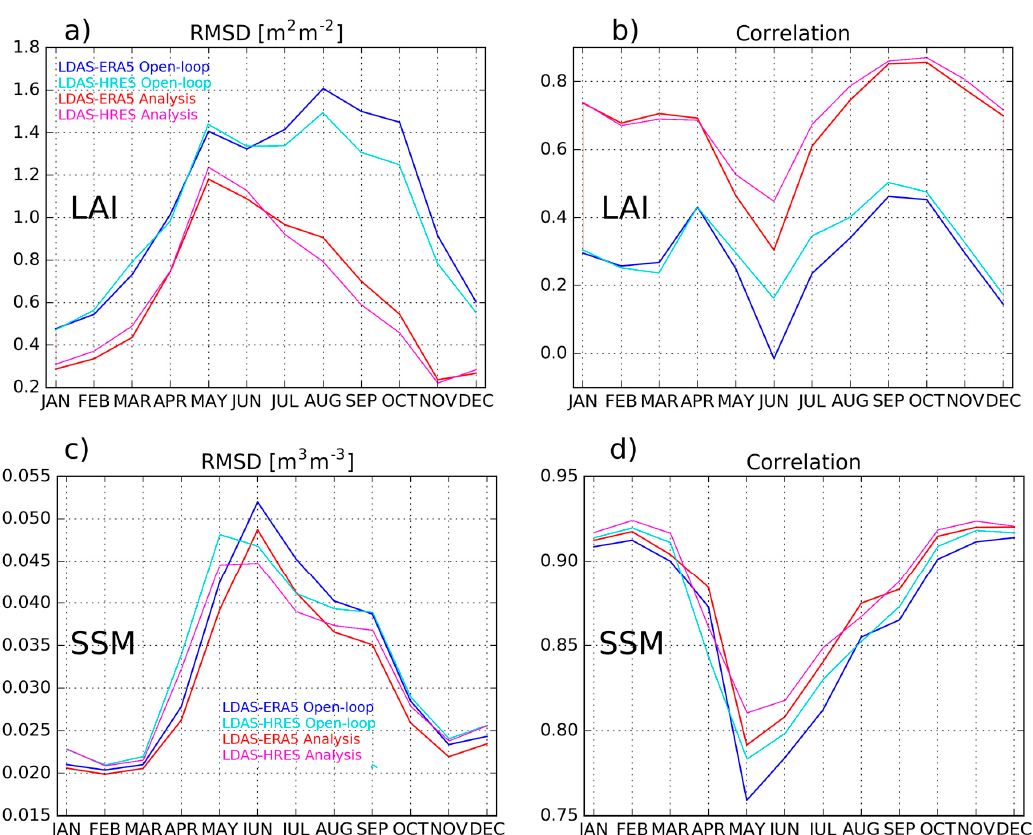
Figure 5. Upper panel, seasonal ( a ) root mean square differences (RMSD) and ( b ) correlation values between leaf area index (LAI) from the model forced by either ERA5 (LDAS-ERA5 Open-loop in blue) or HRES (LDAS-HRES Open-loop in cyan), the analysis forced by either ERA5 (LDAS-ERA5 Analysis in red) or HRES (LDAS-HRES Open-loop in pink) and GEOV2 LAI estimates from the Copernicus Global Land Service project from April 2016 to October 2018. Lower panel, same as upper panel between modeled/analyzed soil moisture from the second layer of soil (1–4 cm) and ASCAT surface soil moisture estimates from the Copernicus Global Land Service project.